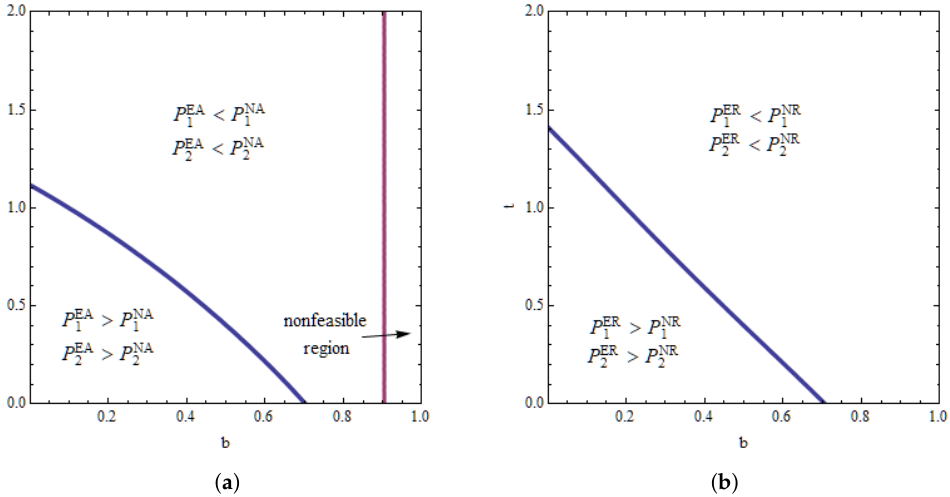
Figure 2. The comparisons of retail prices ( a = 0.5, r = 0.2, c = 0.1). ( a ) under the agency mode. ( b ) under the reselling